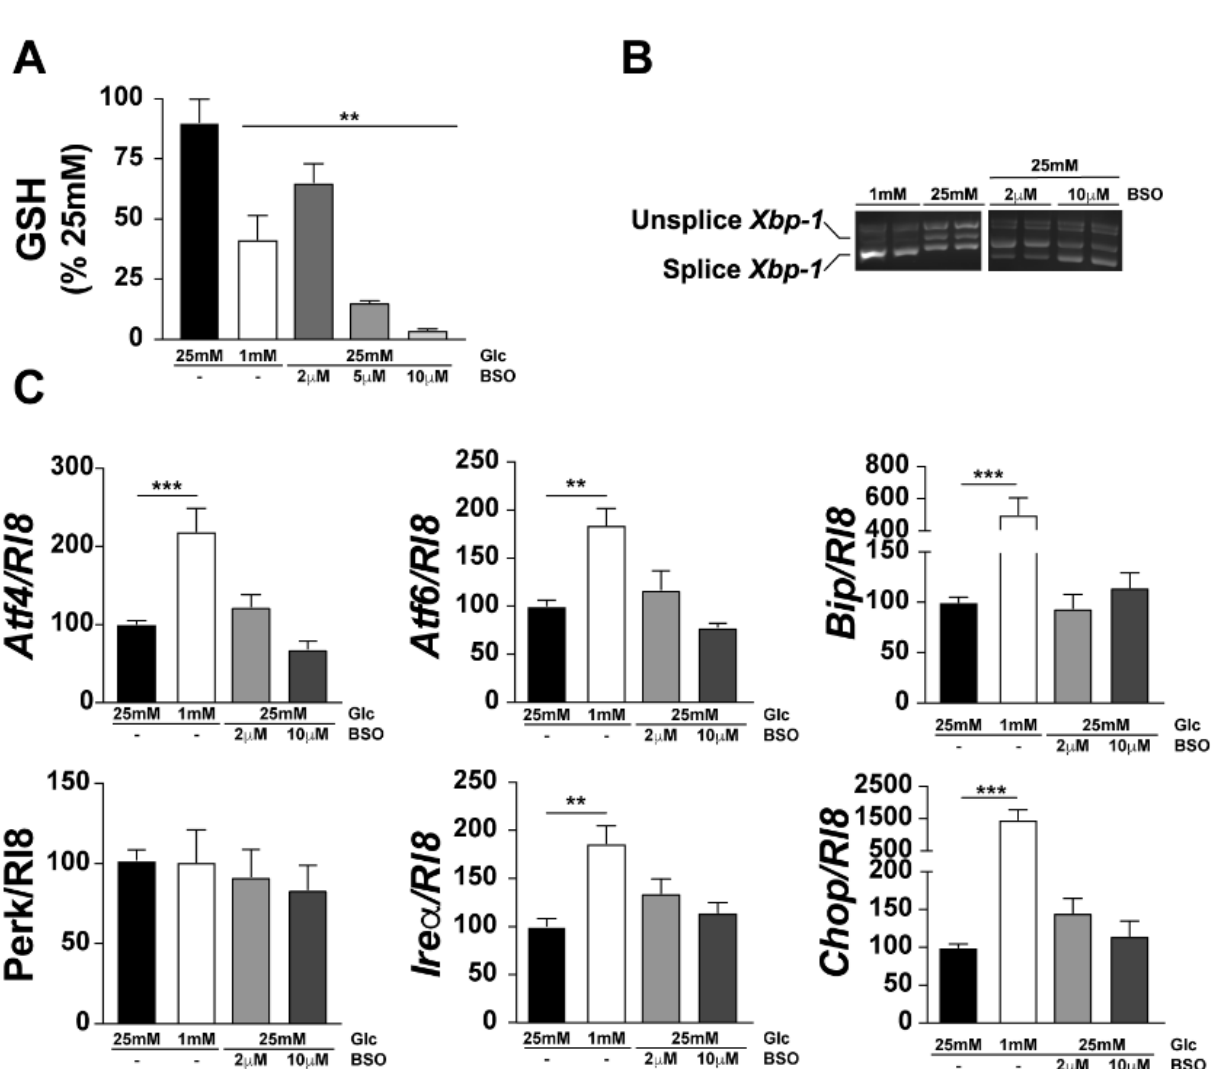
Figure 4. L-Buthionine-sulfoximine (BSO) administration decreases GSH in 661W cells but did not affect ER stress. The 661W cells were cultured with or without BSO (2, 5, or 10 µ M). After treatment, proteins were extracted and quantified, and the GSH concentration was evaluated ( A ). Xbp-1 splicing was evaluated by RT-PCR ( B ), and expression of other ER stress genes were evaluated by qPCR ( C ). Results are expressed as mean ± SEM of 2–3 experiments ( n = 6–9; ** p < 0.005, *** p < 0.0001).